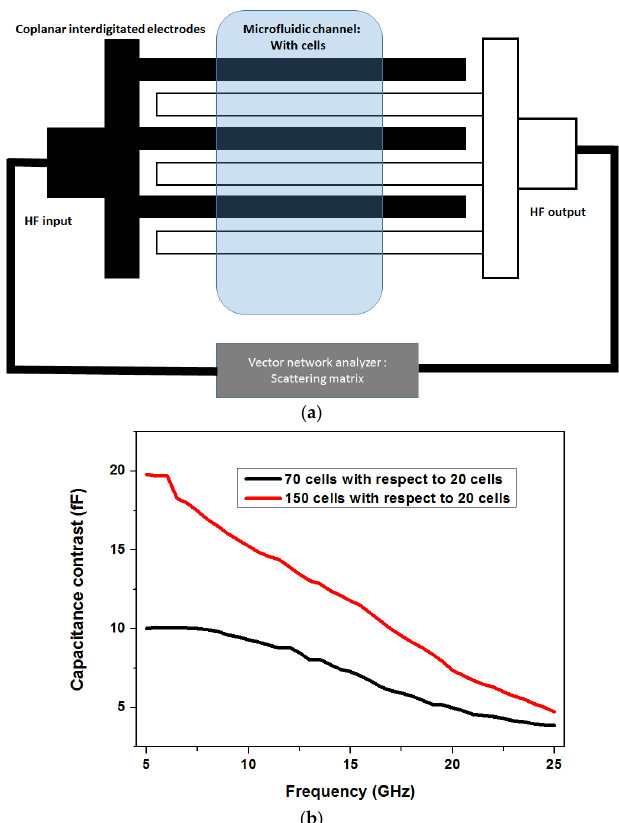
Figure 4. ( a ) Coplanar passive interdigitated capacitor on a microwave substrate integrated with microfluidics; ( b ) Distinction of concentration of cells using the capacitor sensor [42].